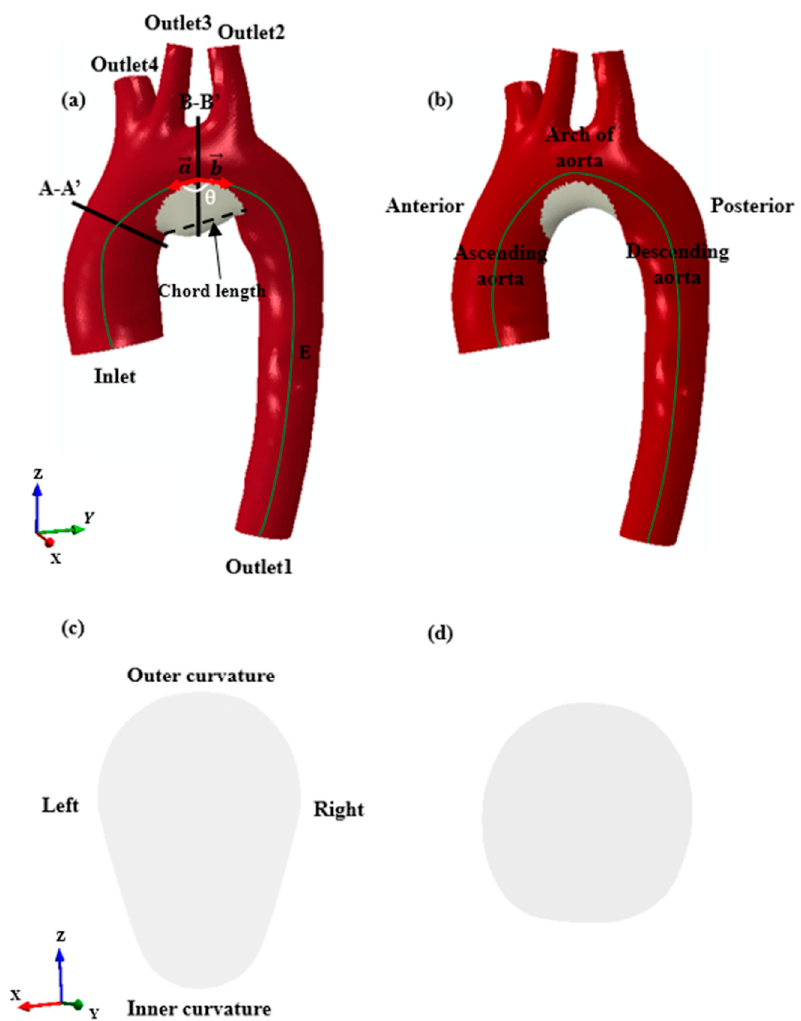
Figure 2. Reconstructed aortic arch repaired with ( a ) a half-moon shaped graft and ( b ) a crescent graft. B-B’ cross-section in ( c ) a half-moon shape model and ( d ) a crescent model.